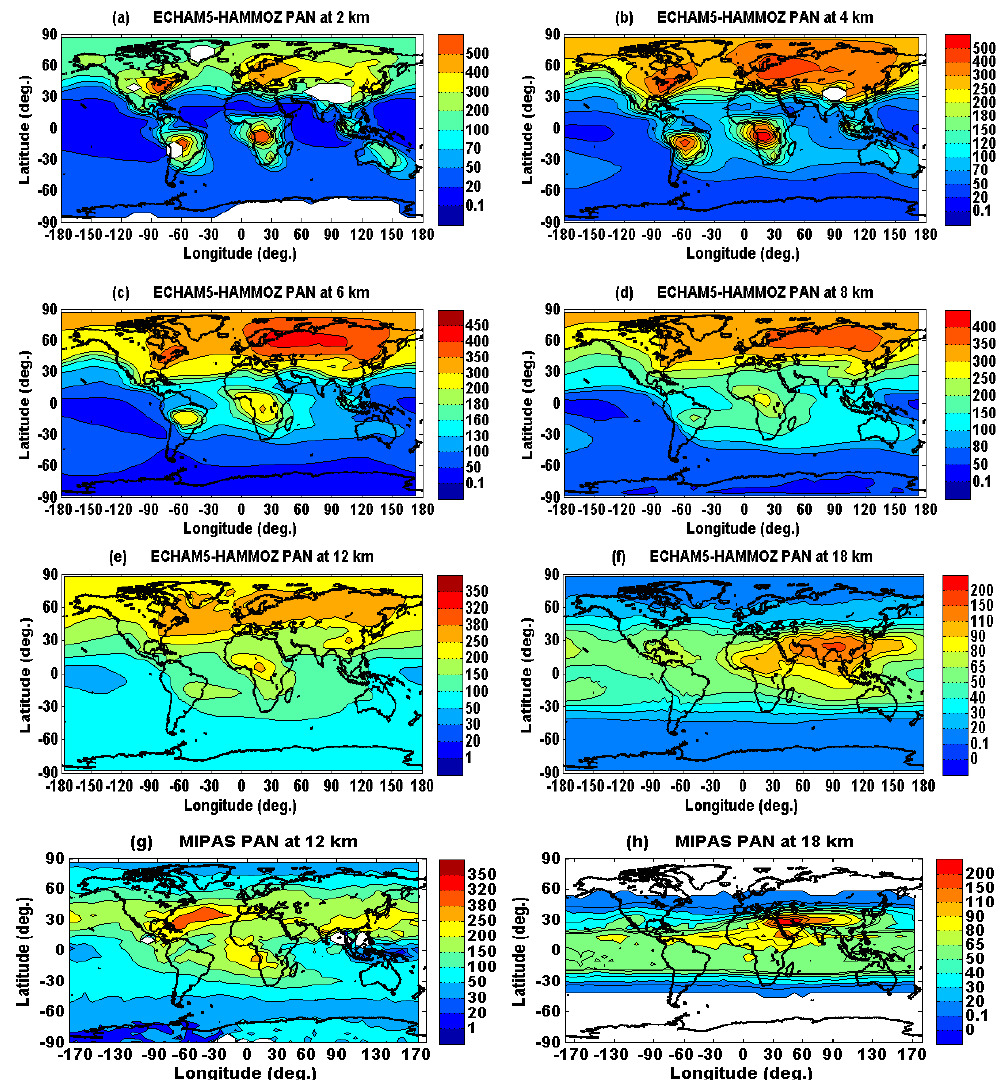
Figure 10. Latitude–longitude cross section of PAN (ppt) averaged for the monsoon season (a) ECHAM5–HAMMOZ simulations at